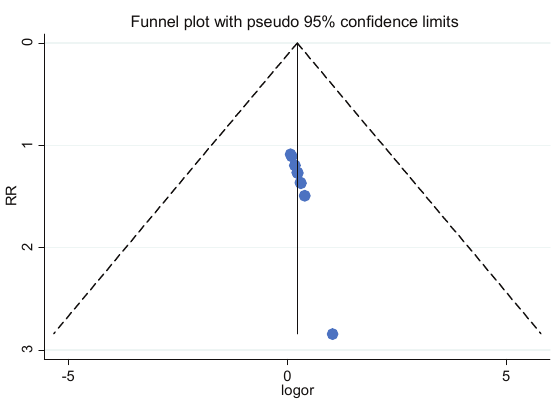
Figure 6: The Begg’s funnel plot for UPDRS score changes of piribe- dil in adjuvant treatment of Parkinson’s Disease